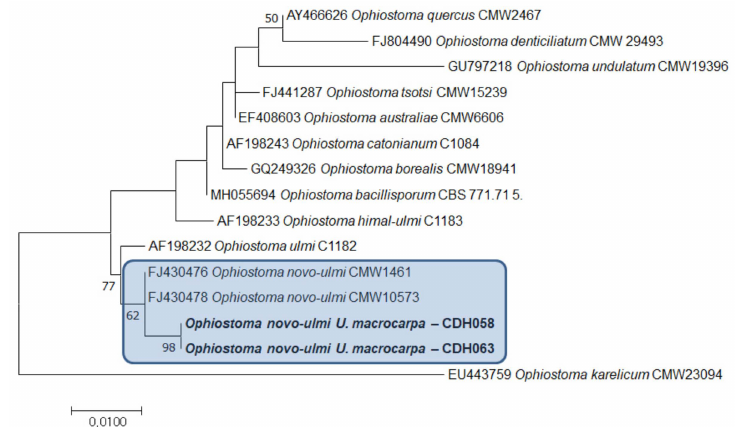
Figure 3. Phylogenetic tree based on maximum likelihood (ML) analysis. Scale bar indicates 0.01